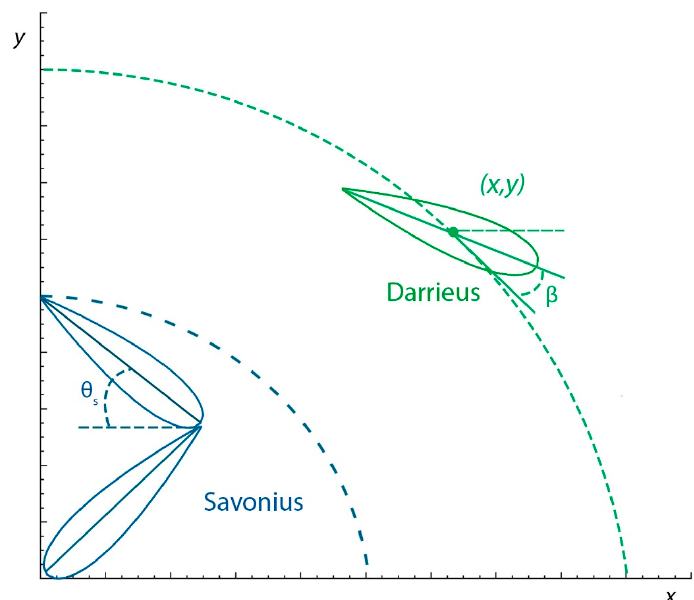
Figure 1. Schematic showing the two independent coordinate systems used to define a single-blade position for the Savonius (blue) and Darrieus (green) configurations.